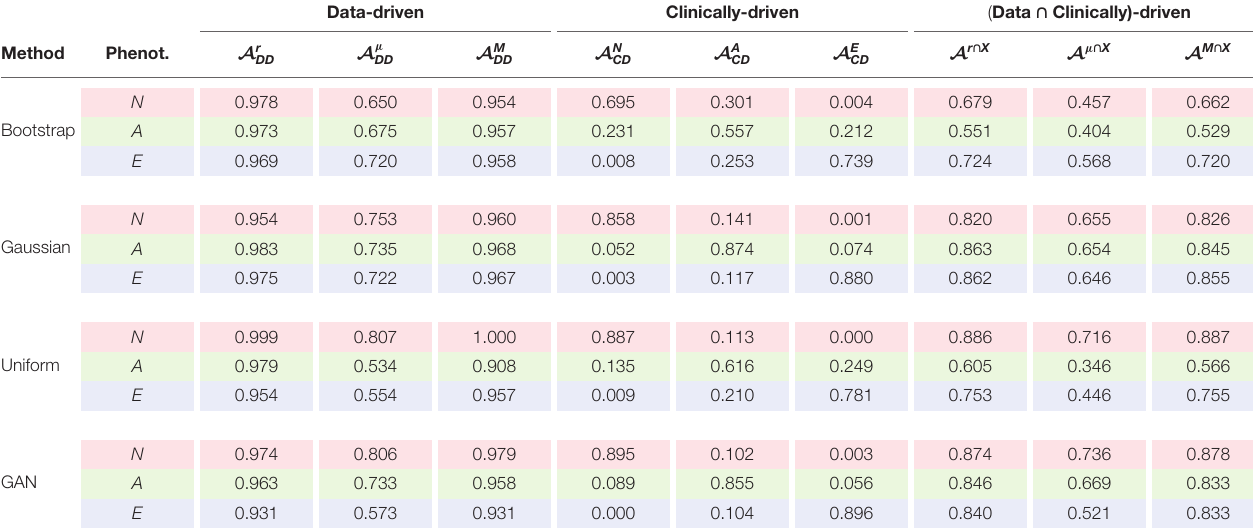
TABLE 5 | Efficiency values achieved by each method and for each biomarker.